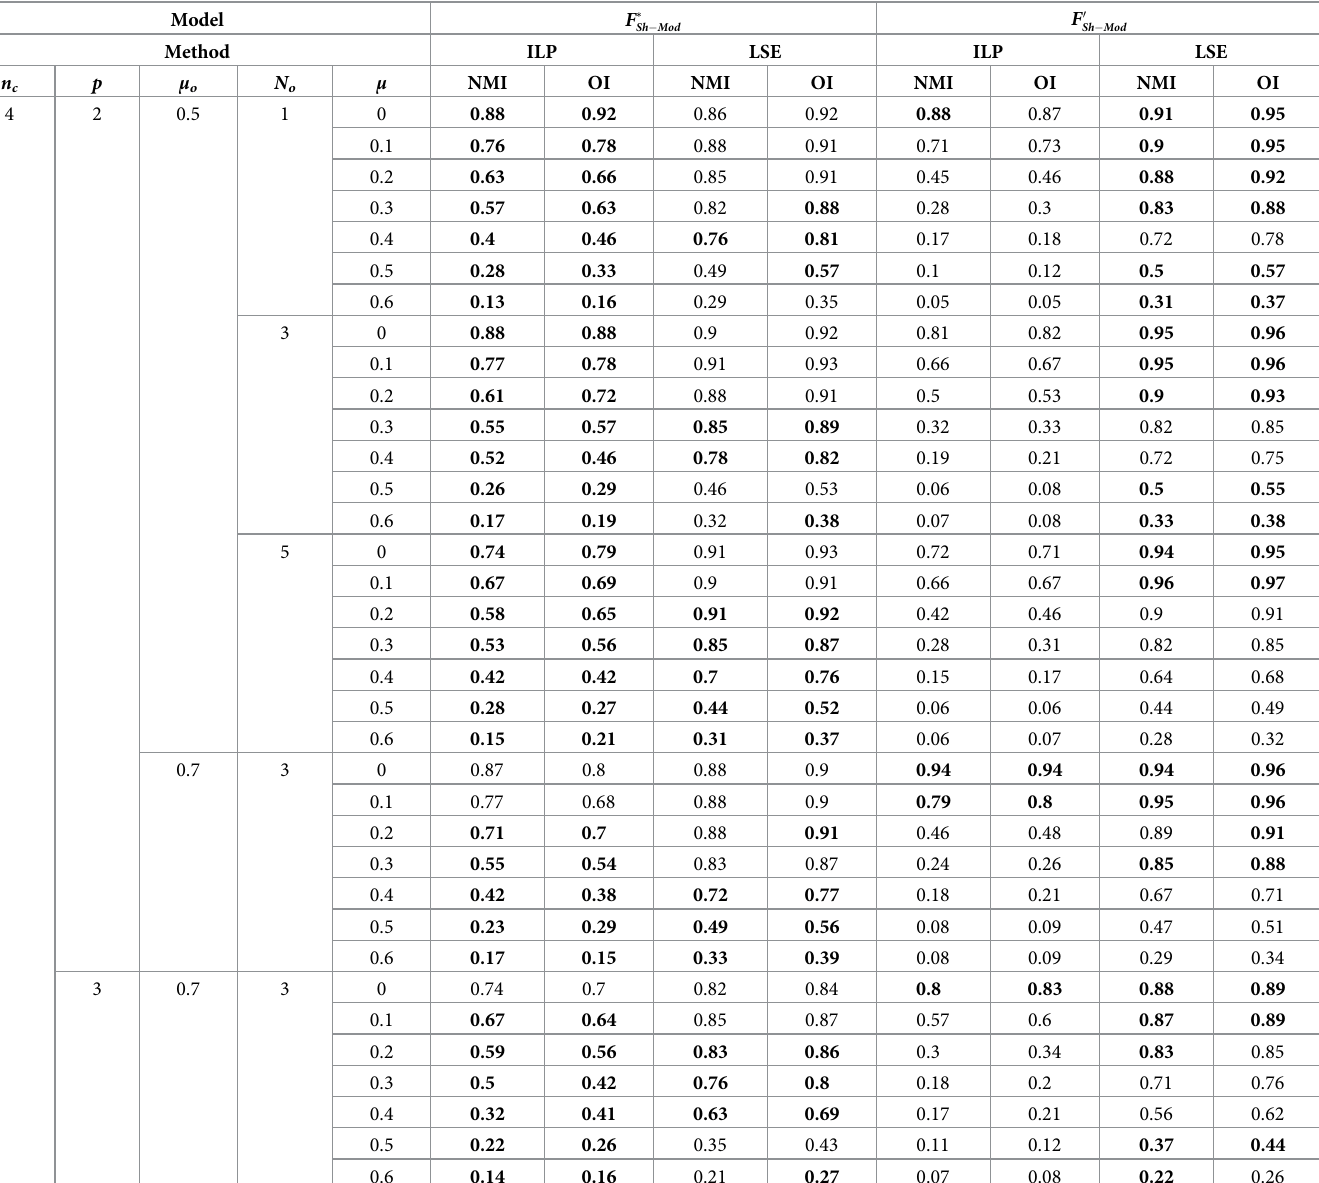
Table 3. Computational results about networks with overlapping communities.